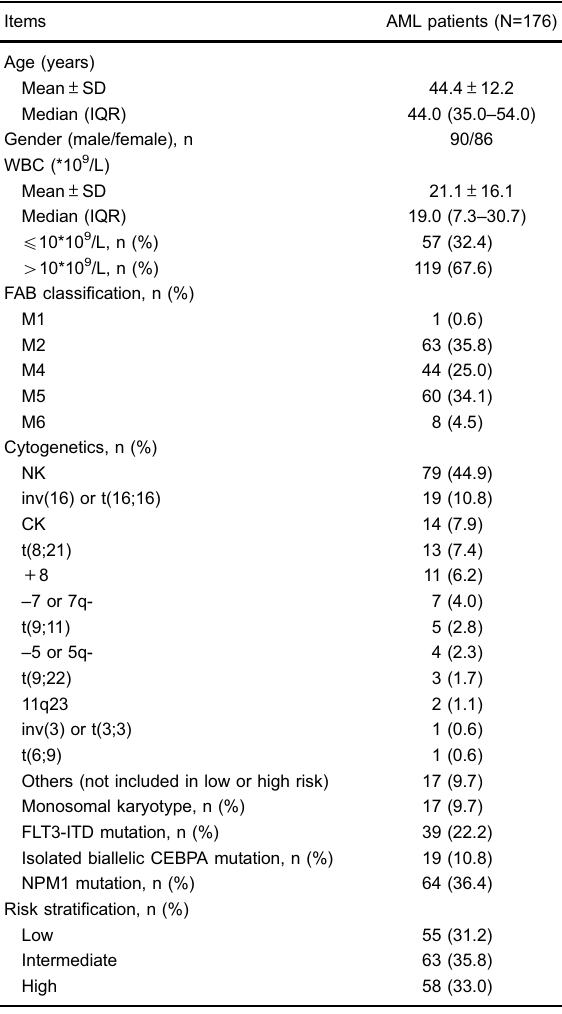
Table 1. Characteristics of acute myeloid leukemia (AML) patients.